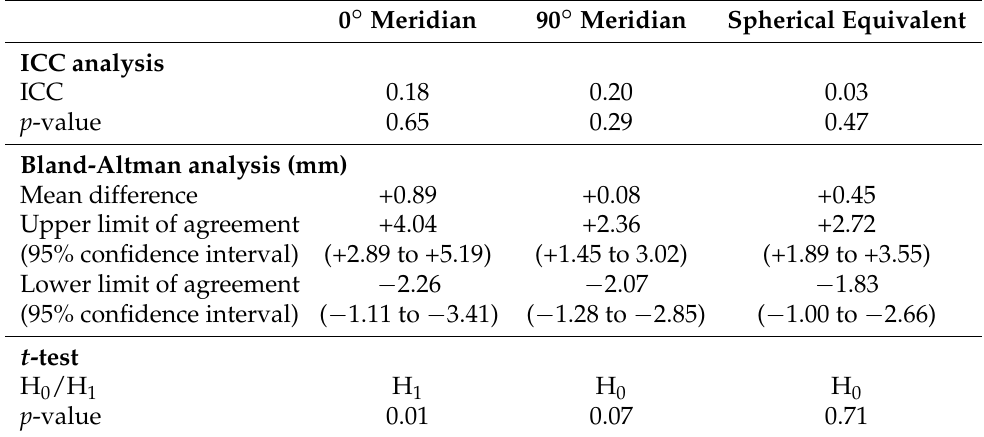
Table 1. t -tests, intraclass correlation coefficients (ICCs), and Bland–Altman analysis of the PRX-based retinal curvature for three refractive profiles versus the OCT-based retinal curvature ( n =25).